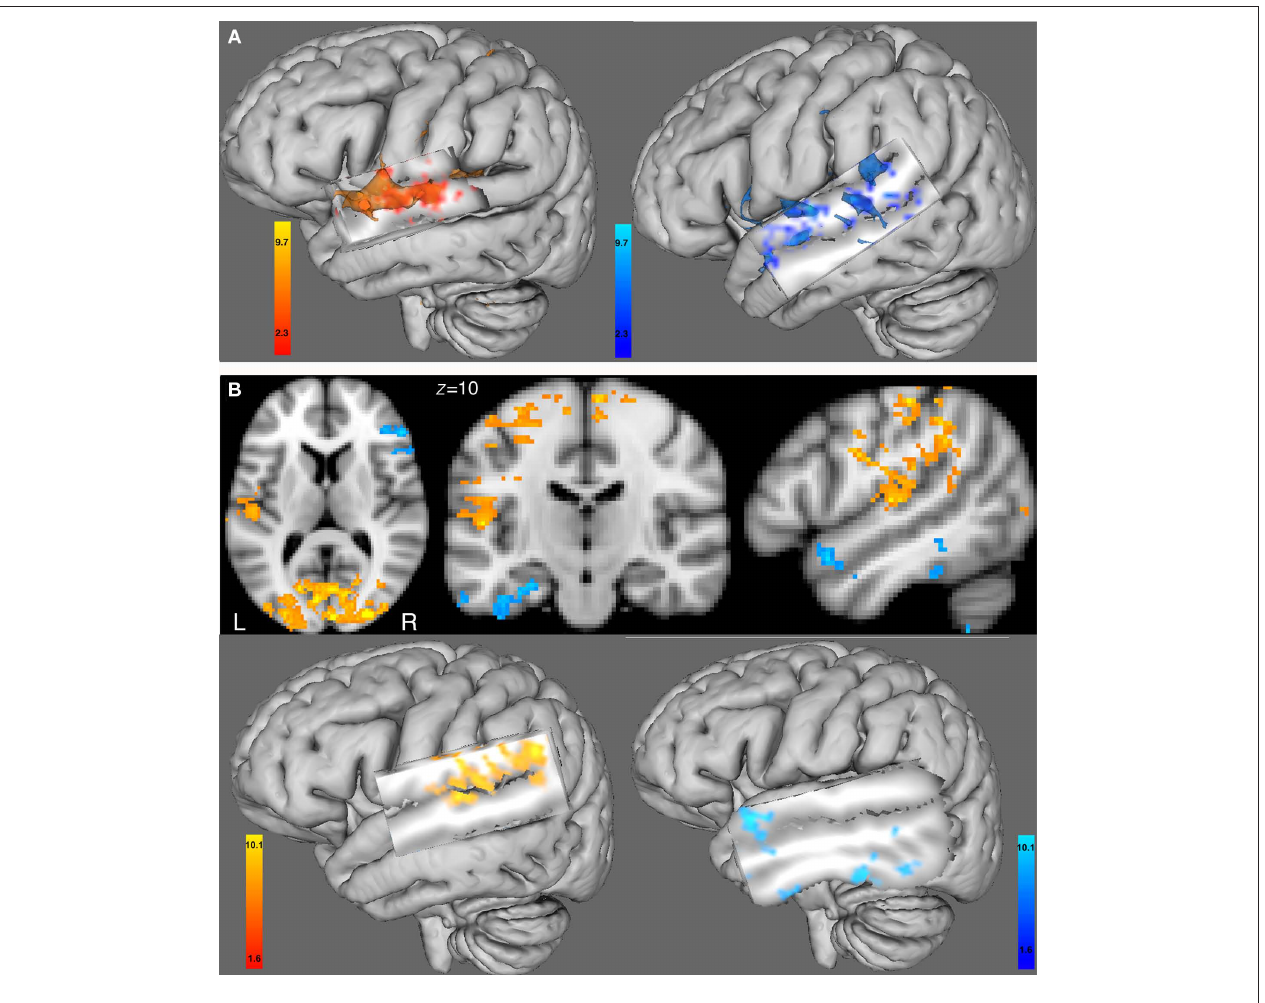
red-yellow: increased in functional connectivity with the right HG in females compared with males; in blue-lightblue: increased in functional connectivity with the right HG in males compared with females (cluster-corrected p < 0.05, z = 1.6). All 3D views were displayed by cutting sagittal slices through the left temporal cortex in order to focus on left